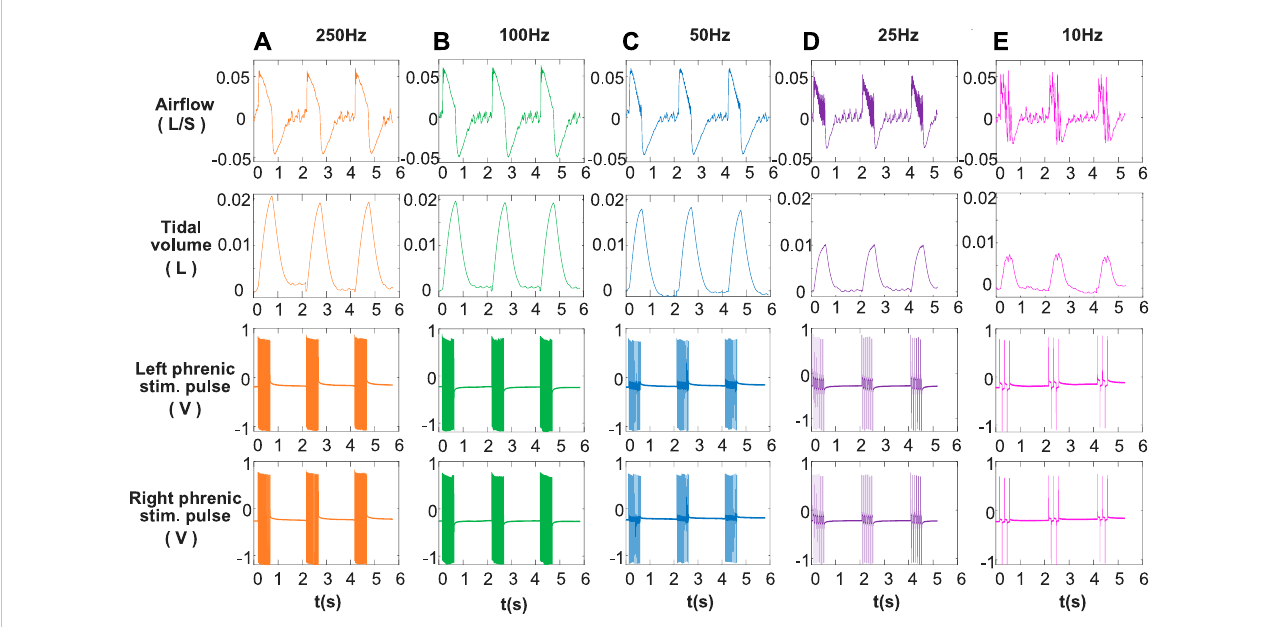
FIGURE 3 Recorded signals at different stimulation frequencies. (A) 250 Hz, (B) 100 Hz, (C) 50 Hz, (D) 25 Hz, (E) 10 Hz for air fl ow, tidal volume, left phrenic stim. pulse and right phrenic stim. pulse signals in a rabbit. Other respiratory stimulus parameters including amplitude, respiratory rate, pulse width, and inspiratory time were same, for 1 mA, 30 breath/min, 160 μ s and 0.5 s respectively. The smoothness of the air fl ow waveform increases with stimulation frequency (10 – 250 Hz). Increasing the frequency of stimulation results in an increase in tidal